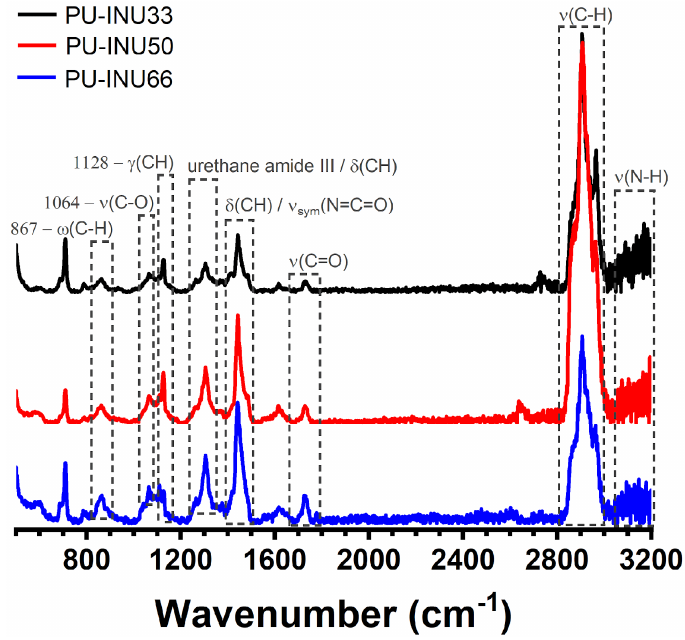
Figure 2. Raman spectra from PU–INU based materials and their adsorption characteristic bands.